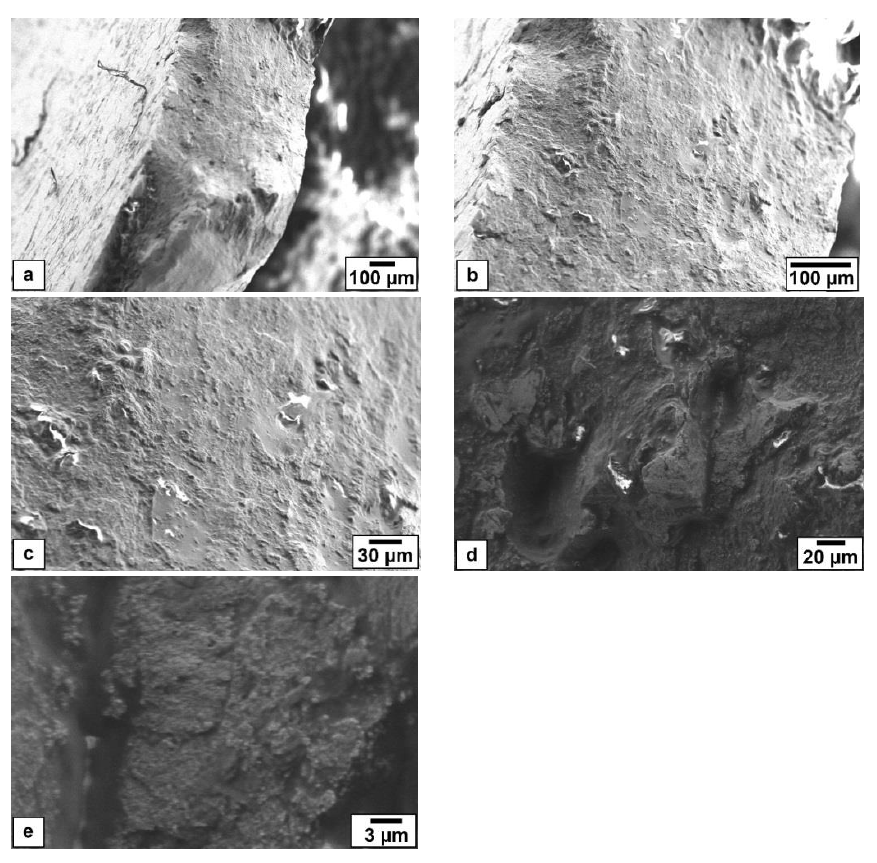
Fig. 6. Fractography images of Al-alloy/Mg-alloy/Al-alloy sandwich